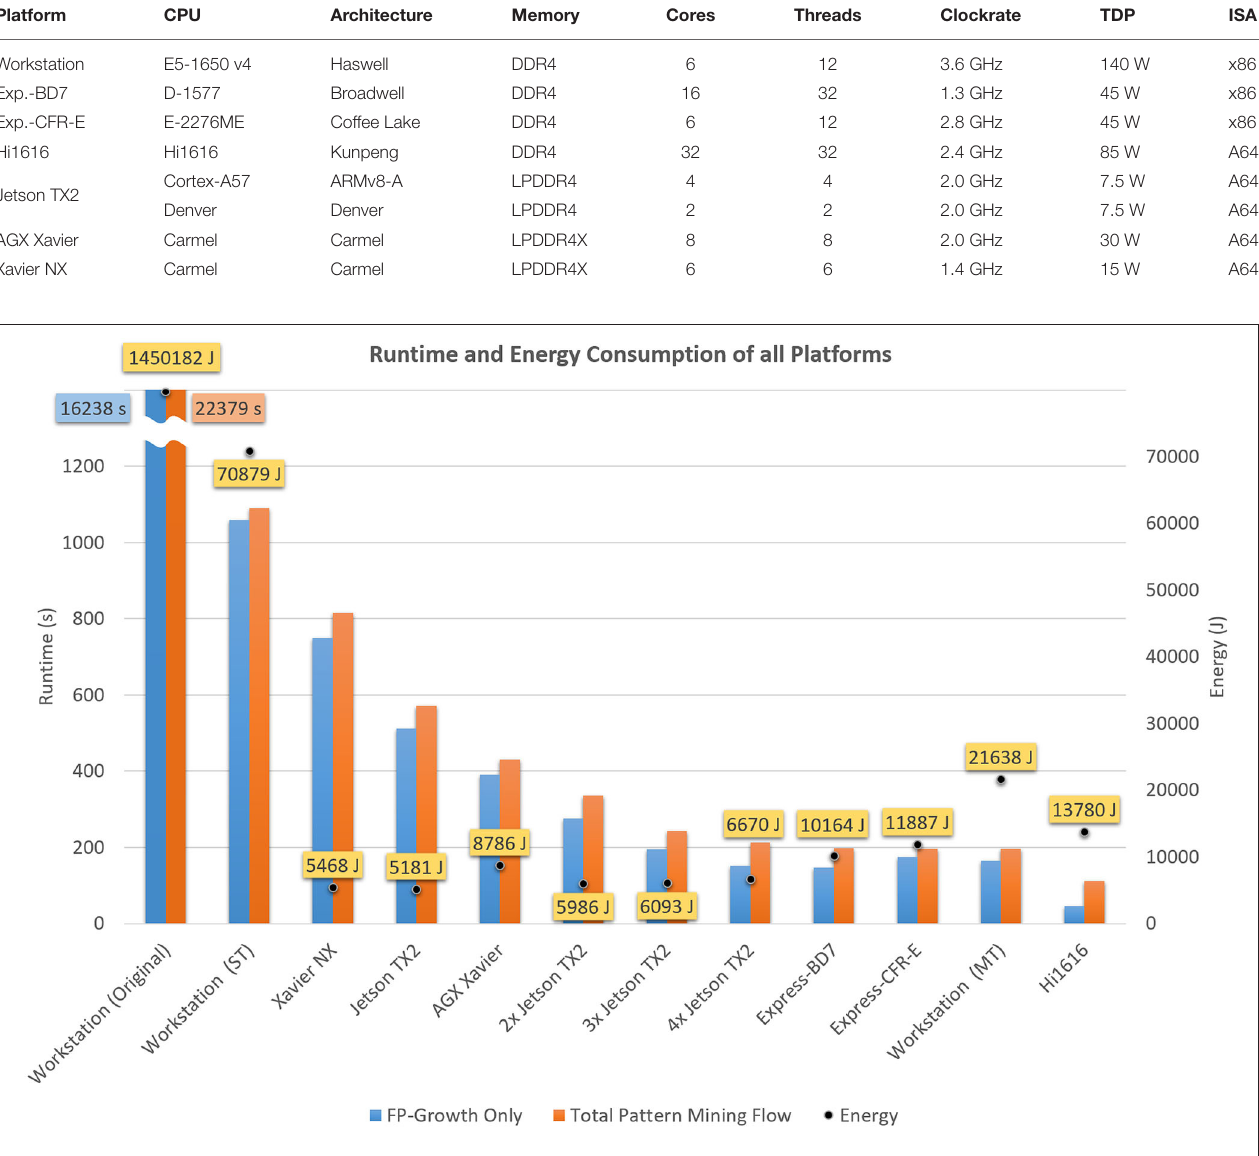
FIGURE 6 | Runtimes of the optimized flow on all considered platforms (cf. Table 7 ). MT refers to the multi-threaded, ST to the single-threaded and Original to the baseline (currently used) version. A detailed overview over the different platforms and their features is presented in Table 9